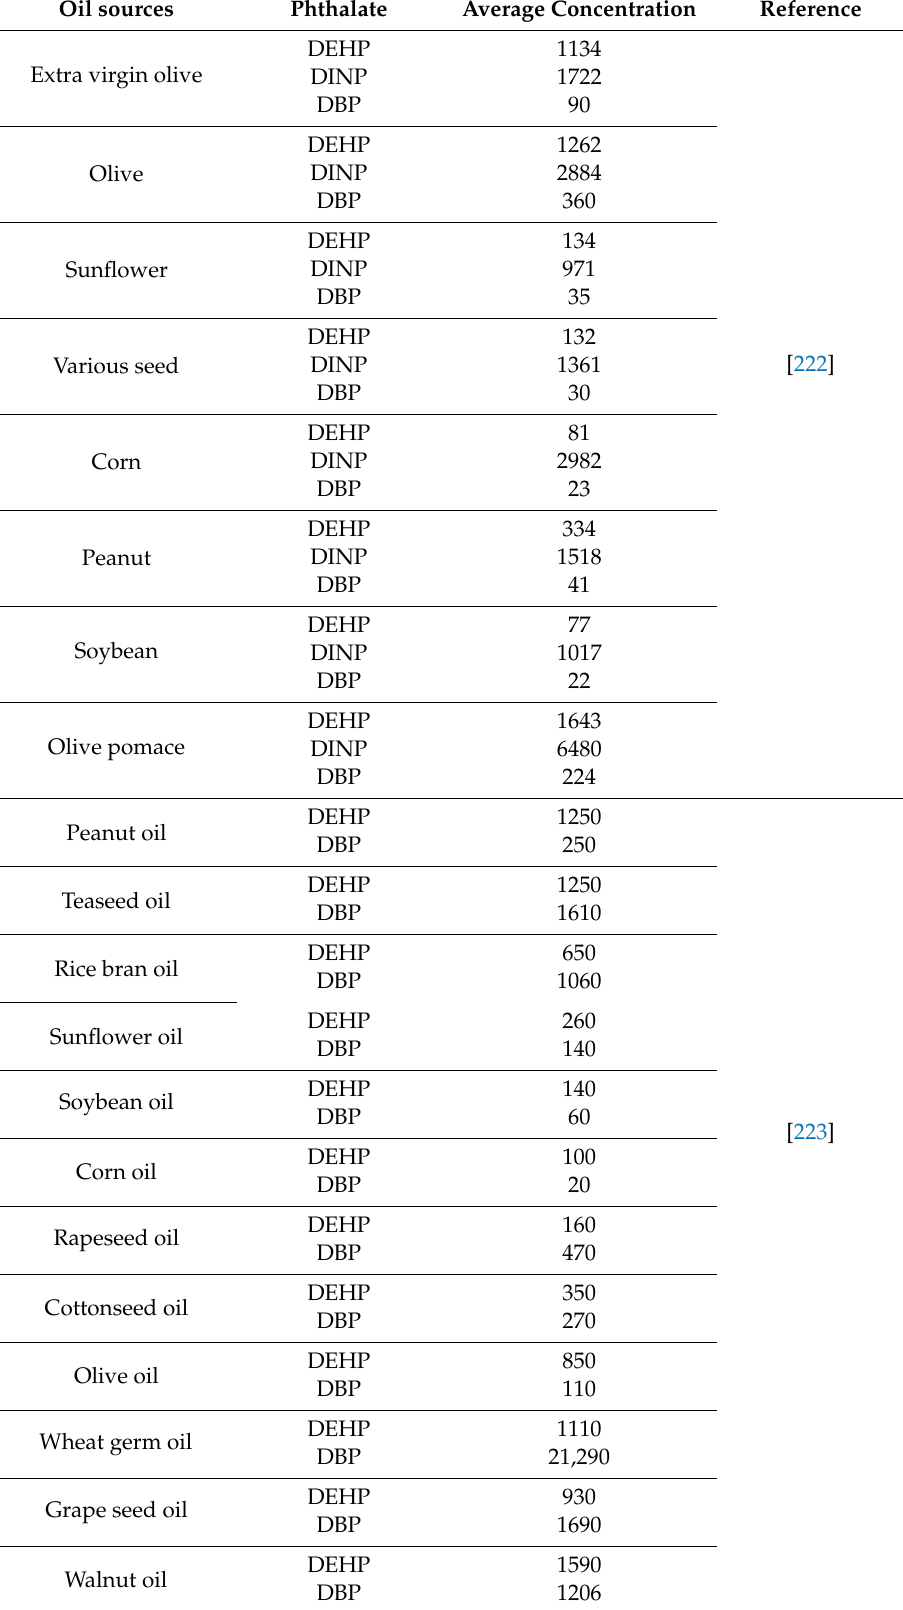
Table 5. Occurrence of phthalates in vegetable oils from di ff erent plant sources ( µ g Kg − 1 ). Oil sources Phthalate Average Concentration Reference DEHP 1134 Extra virgin olive 1722